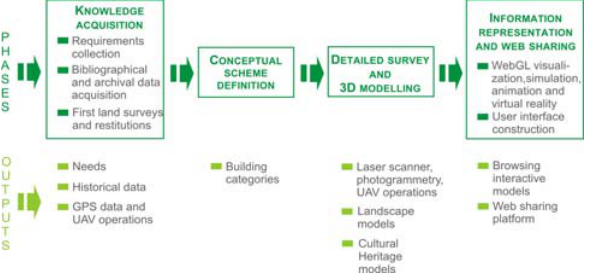
Figure 5. The methodological